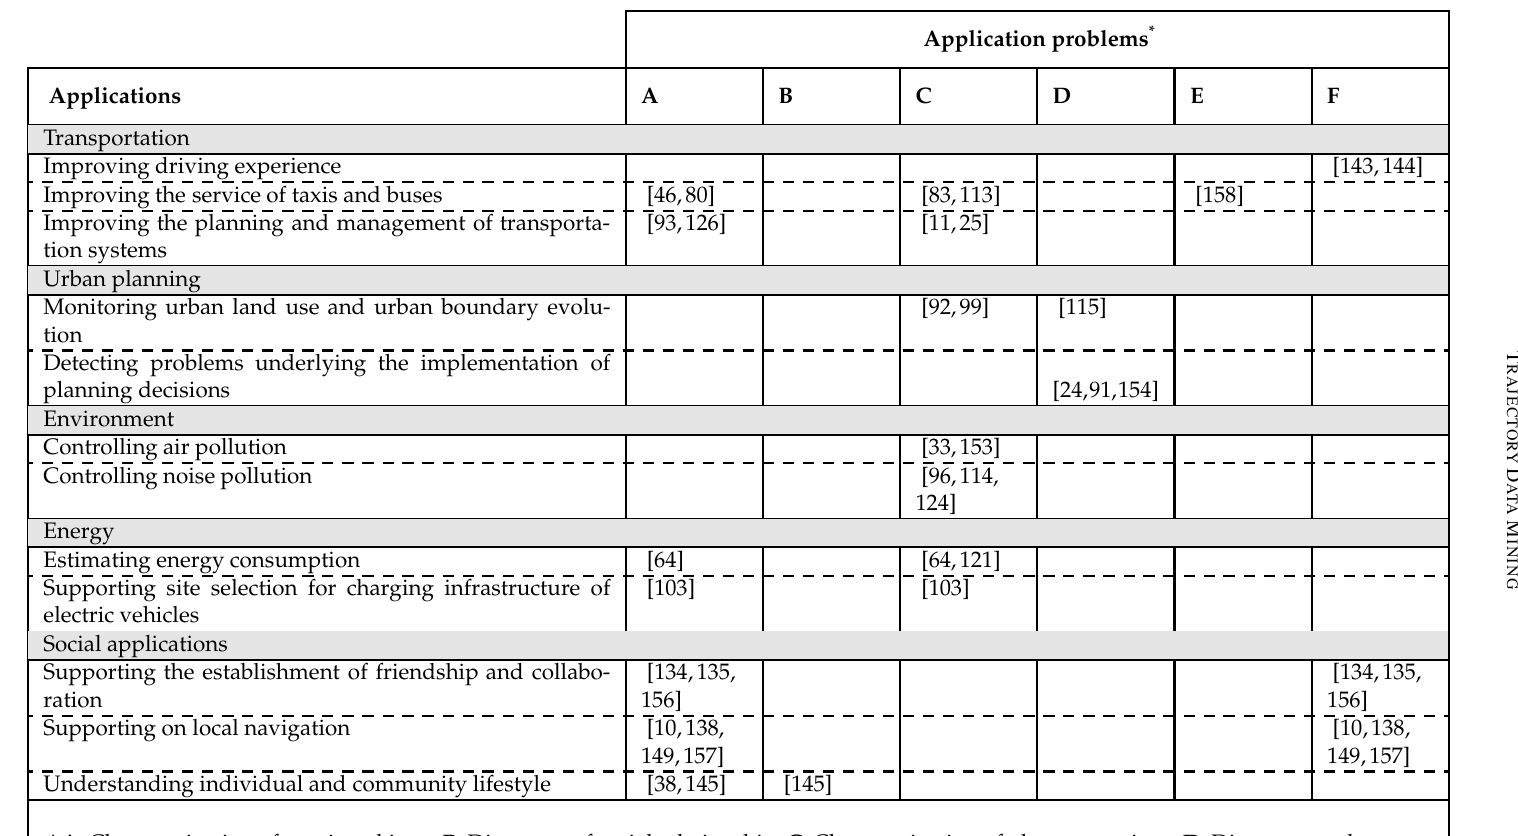
Table 3: Applications of trajectory data mining and corresponding application